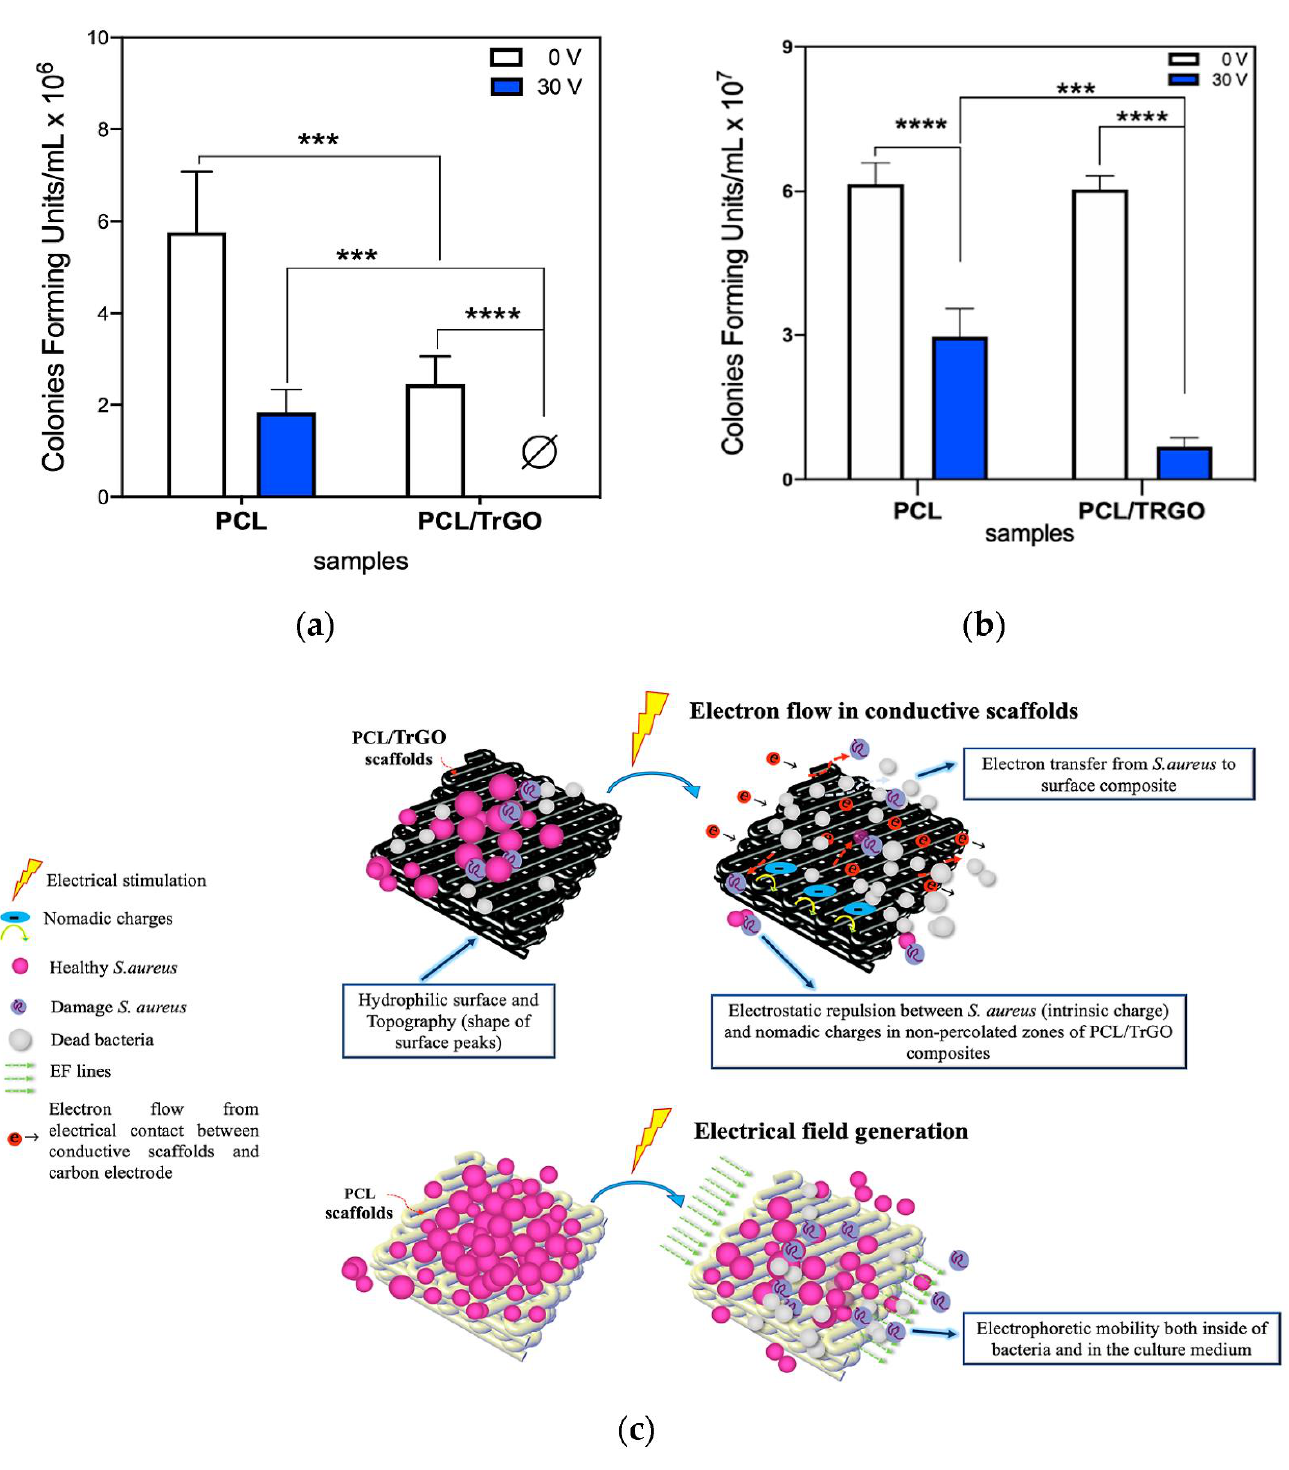
Figure 5. ( a ) Colony-forming units for the experiments performed at 0 V and under electrical stimuli (30 V) for neat PCL and PCL/rGO nanocomposite. ( b ) CFU in scaffolds taken from the bioreactor after 3 h of incubation at 0 V and 30 V. *** and **** denote a significant difference with a value p < 0.001 and p < 0.0001, respectively, with the control sample PCL 0 V and between the samples indicated, n = 3 independent experiments were performed in triplicate per sample ( c ) Depiction of the probable mechanism of antibacterial action for PCL/rGO without electrical field and for PCL and PCL/TrGO under stimulation at 30 V. Taken from Ref. [71].